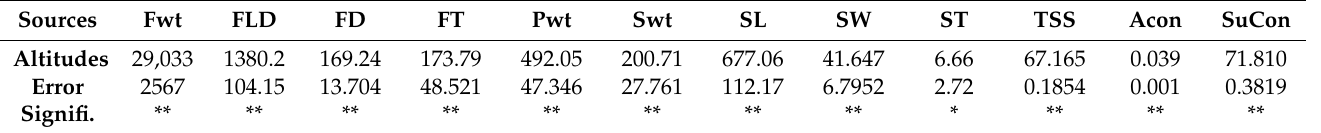
Table 1. Analysis of variance (least square fit model) table showing mean square values and the significance of different parameters pooled over different